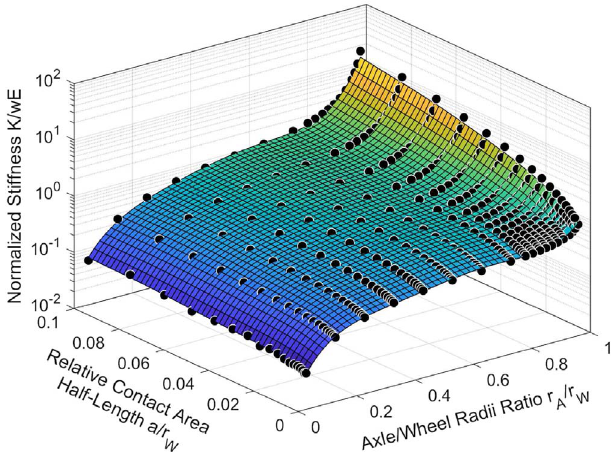
Figure 9. Fifth order homogeneous bivariate polynomial for normalized wheel stiffness as a function of both axle/wheel radii ratio and relative contact area half-length. Plotted on a logarithmic z -scale (base 10).